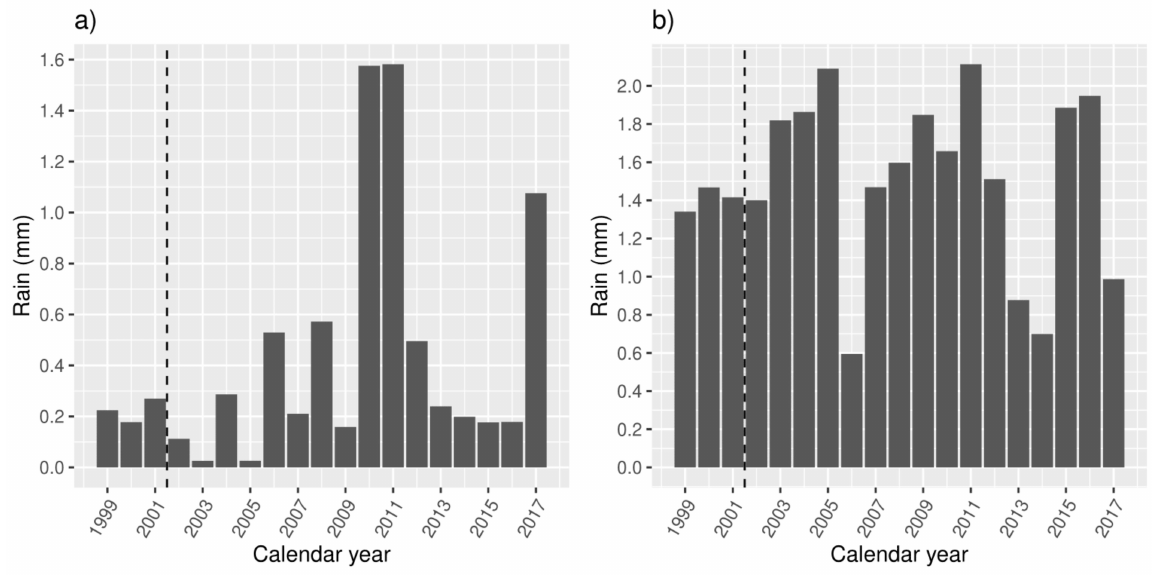
Figure 5. Mean daily summer and winter rainfall (mm) by year. ( a ) Summer (December–February); ( b ) winter (June–August). The dashed line indicates the beginning of available MHED